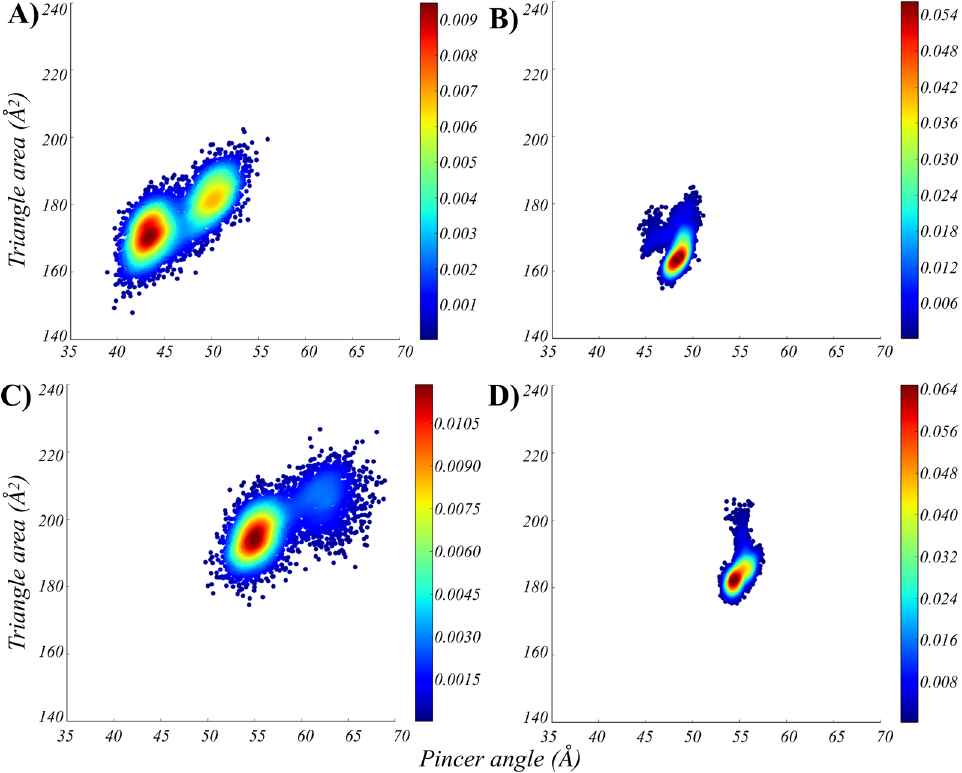
Figure 4. Description of the conformational ensembles of MtInhA associated with NADH and NADH:THT. The probability density plots of ( A ) monomeric MtInhA:NADH, ( B ) tetrameric MtInhA:NADH, ( C ) monomeric MtInhA:NADH:THT, and ( D ) tetrameric MtInhA:NADH:THT highlights the differences of the conformational ensembles. Image generated with MatPlotlib 37